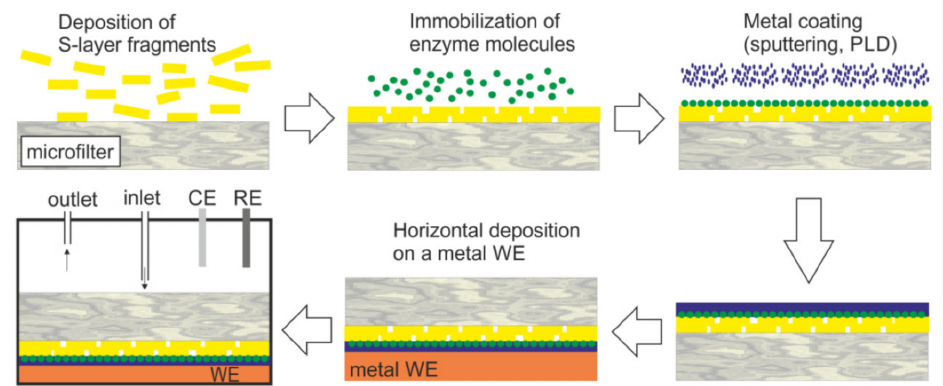
Figure 6. Generalized scheme of the construction of an S-layer ultrafiltration membrane (SUM)-based biosensor (not drawn to scale). S-layer carrying fragments or self-assembly products are deposited on a commercially available microfilter in a pressure-dependent process. The enzyme is deposited on the S-layer surface and chemically linked to the S-layer protein. The immobilized enzyme is contacted by a thin metal layer (PLD: Pulse-laser-deposition). Finally, this composite structure is deposited with the metal layer side on the working electrode (WE) and mounted in a flow cell (RE: Reference electrode, CE: Counter electrode). The analyte is pumped into the flow cell. After passage across the modified SUM, the analyte reacts with the enzyme. This reaction can be detected by amperometry. (With permission from Ref. [98] (CC BY